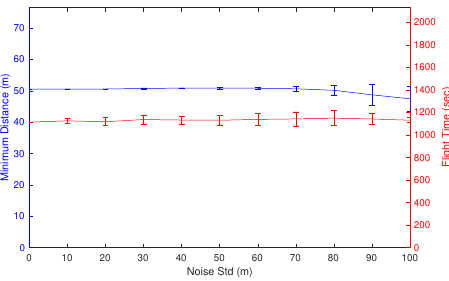
Figure 7. Effect of sensor noise variance on the minimum distance and total flight time.